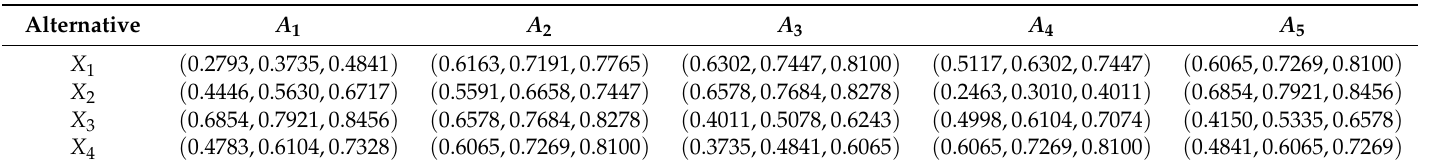
(cid:16) (cid:17) (cid:16) (cid:17) = ( g L ) , g M , g U . (cid:101) g ij ij ij ij 4 × 5 4 × 5